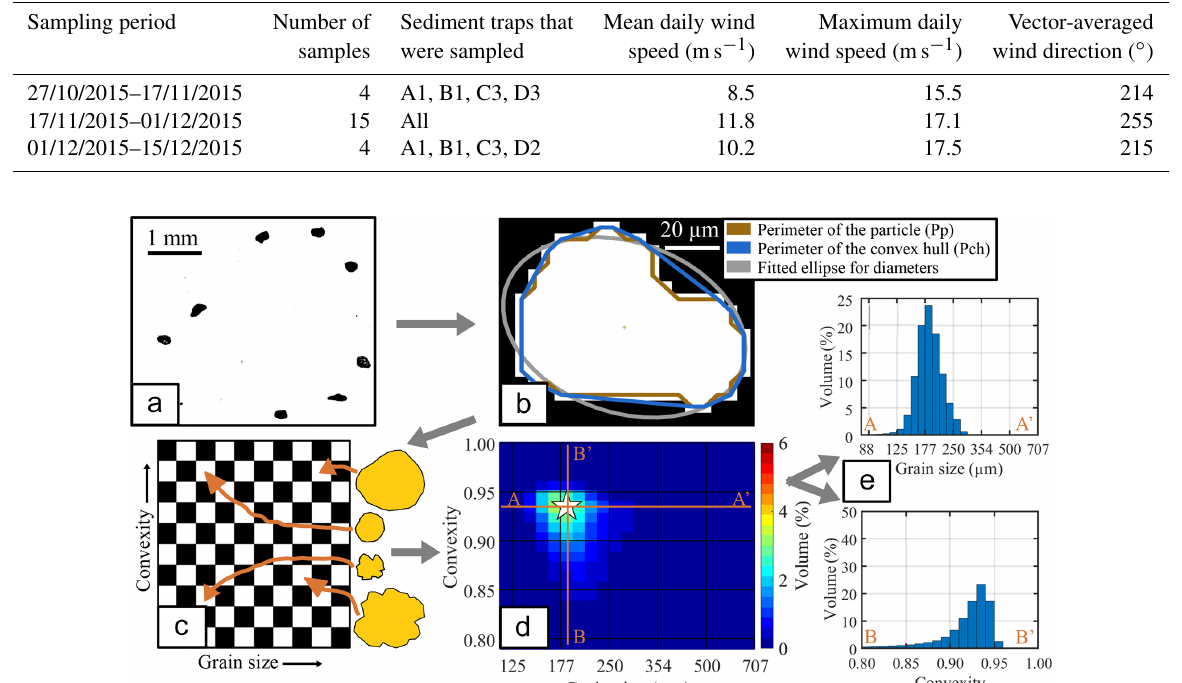
Table 1. Wind conditions and sampling periods of the sediment-trap samples. Sediment-trap names are in reference to Fig. 1b. Meteorological data were obtained from weather station IJmuiden, 3.5km north of the fieldwork area. Dates are listed in the format dd/mm/yyyy.